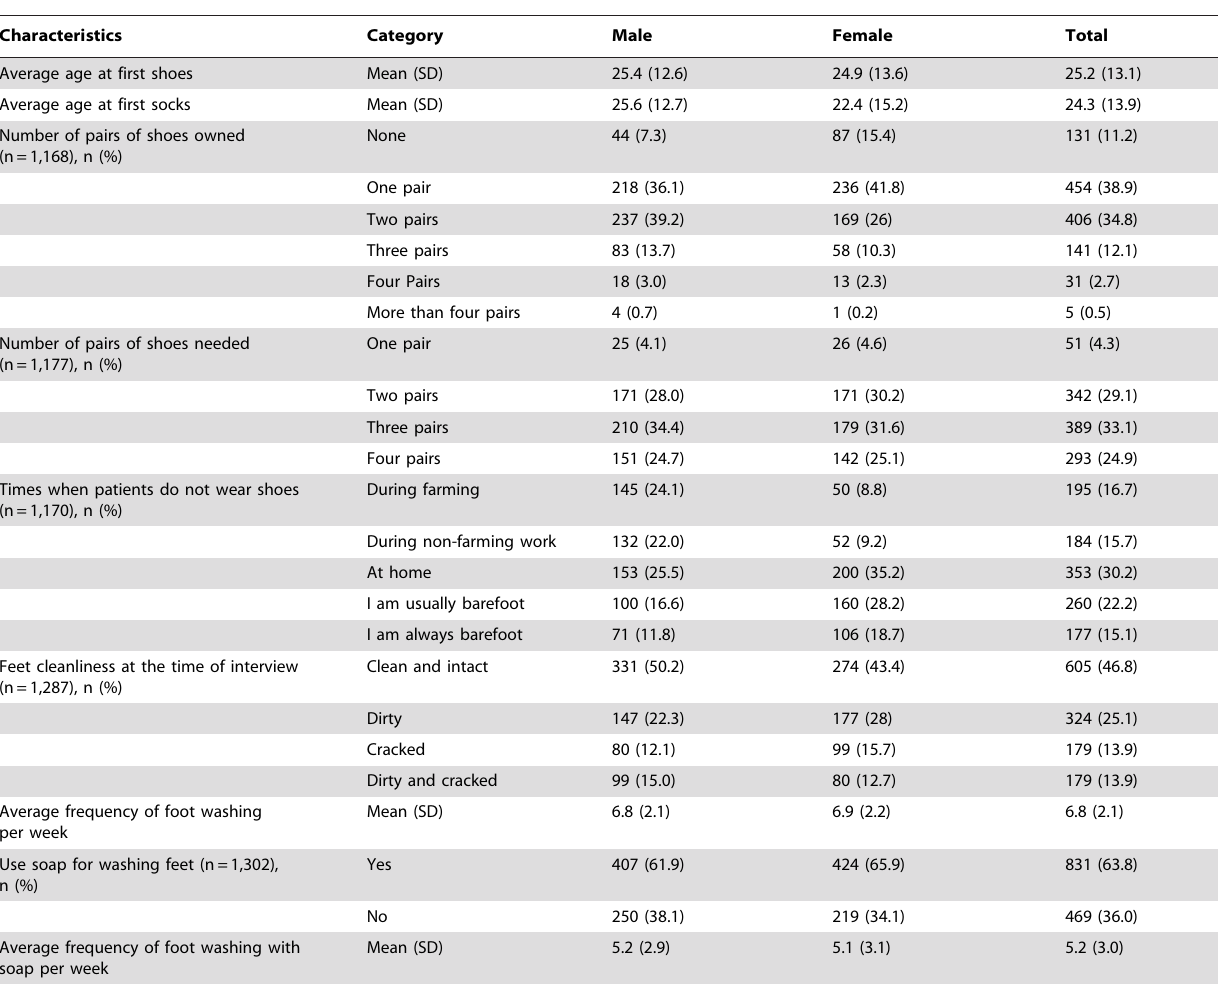
Table 5. Shoe wearing and foot washing experience of